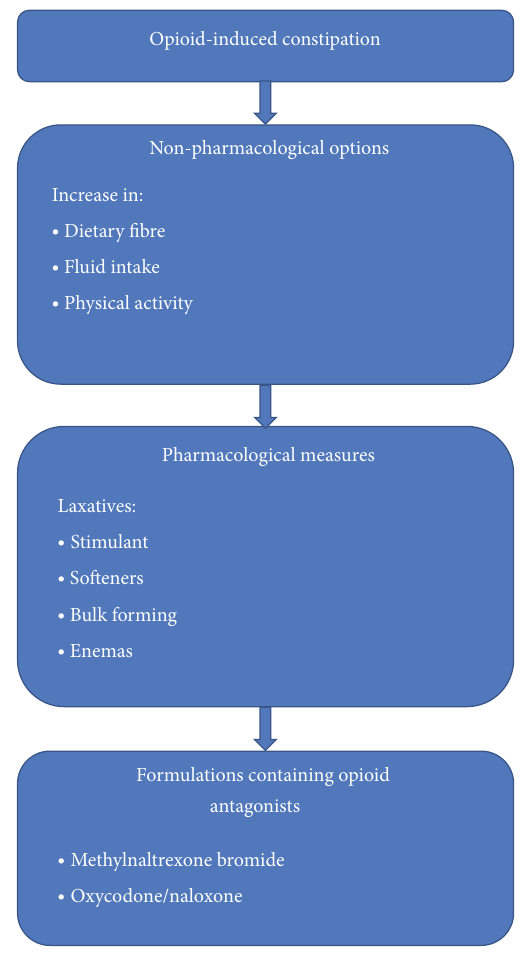
Figure 1: Treatment pathway for opioid-induced